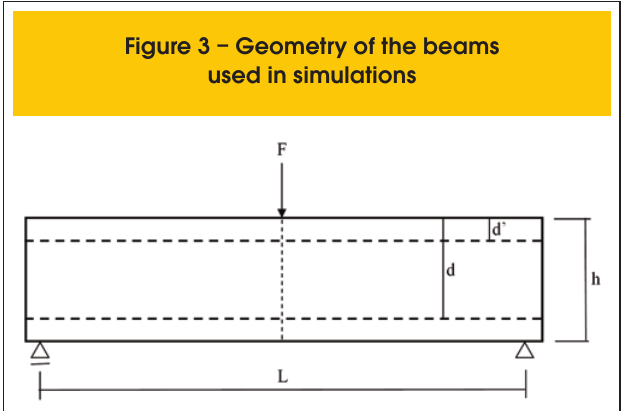
Figure 3 – Geometry of the beams used in